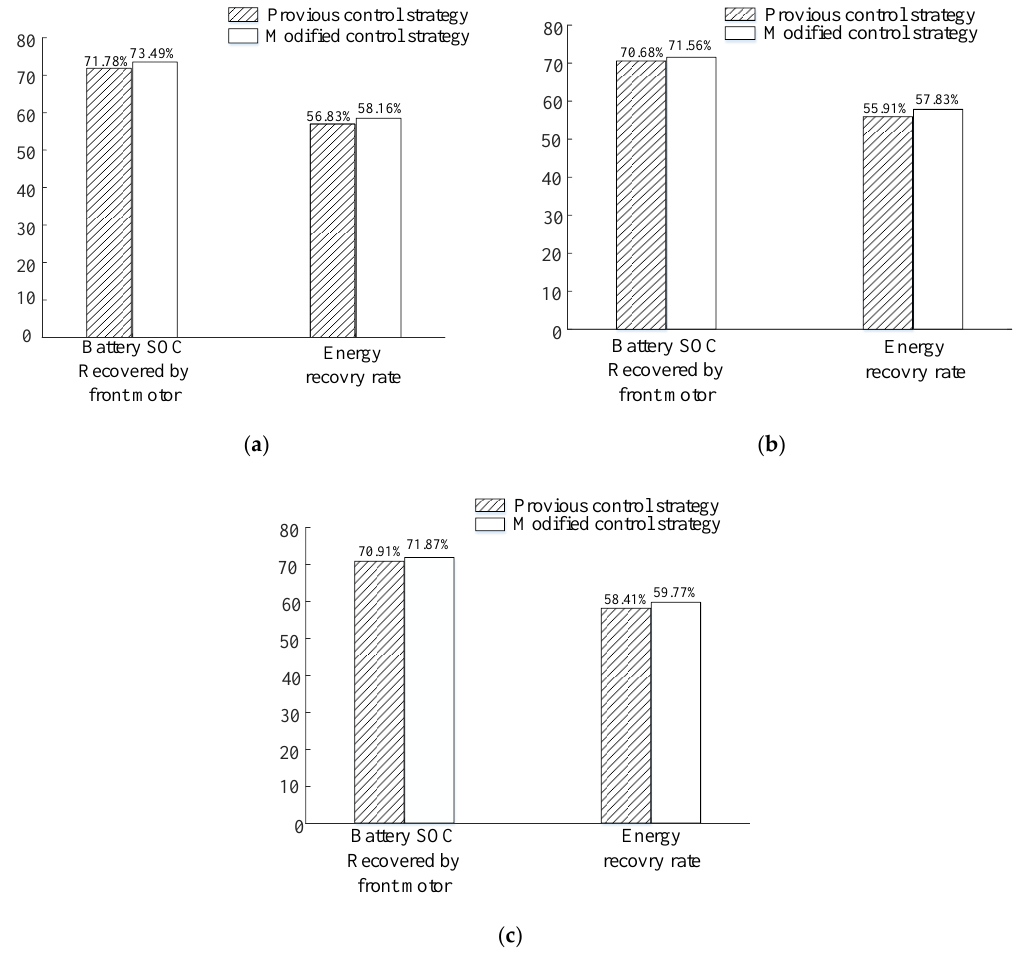
Figure 19. Energy recovery comparison. ( a ) UDDS simulation results comparison; ( b ) NYCC simulation results comparison; ( c ) US06 simulation results comparison.